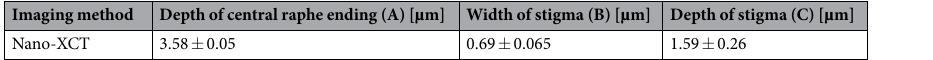
Table 2. Average values with standard deviations of other parameters of the D. geminata cell structure from the nano-XCT tomography data set (marked in Figs 2 and